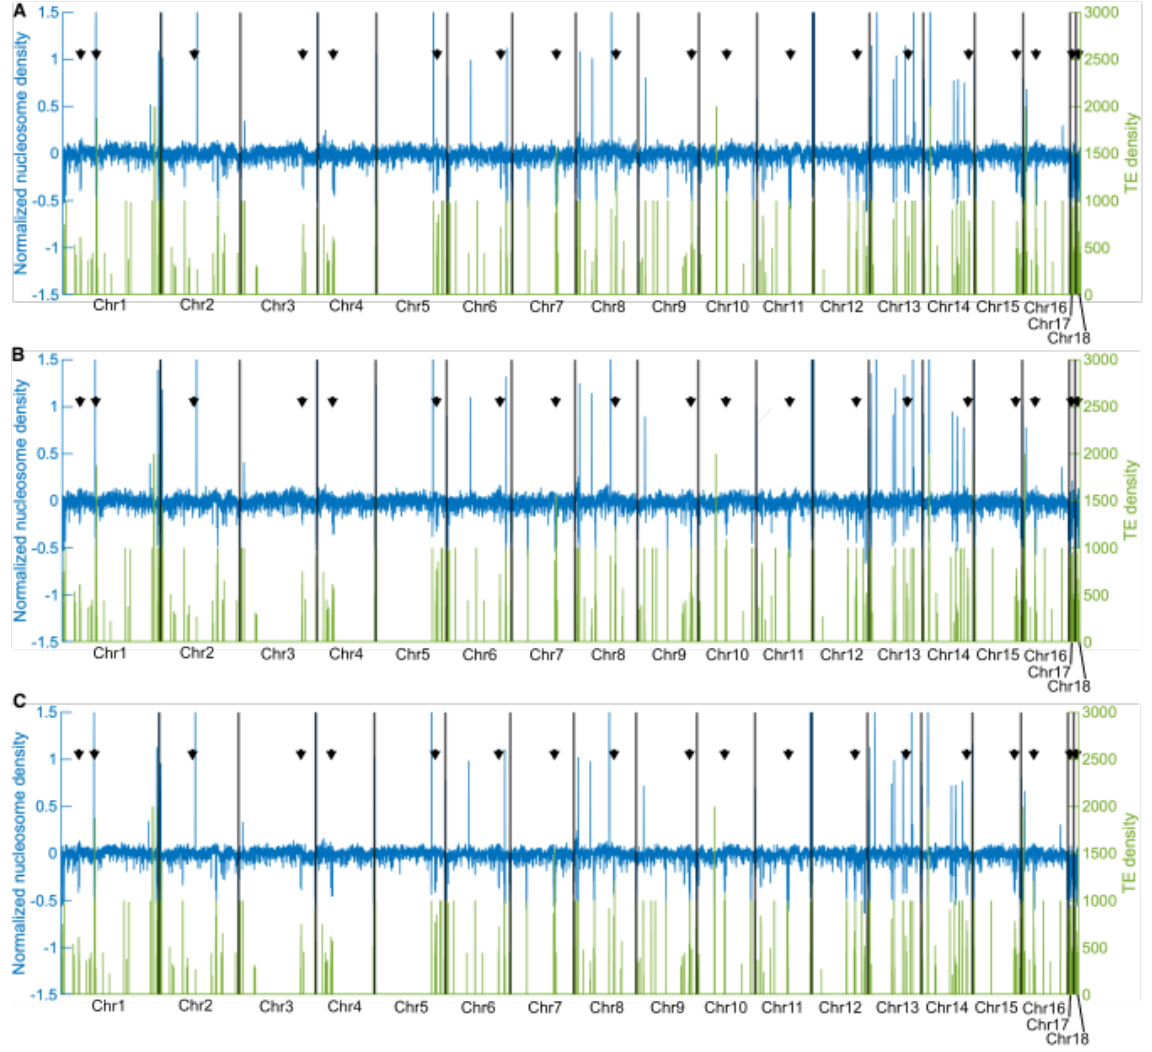
Supplementary Figure 3. Nucleosome vs . TE (other than BOTY) density profiles in individual biological replicates of Botrytis cinerea . Coverage density profiles were computed for non-overlapping 1 kb-long bins along the chromosomes. In green are plotted TE (excluding BOTY) density profiles as previously described (Diolez et al. , 1995). In blue are plotted the z-scored nucleosome density profiles. Black arrows indicate centromeres. ( A) . Biological replicate #1; ( B) . Biological Replicate #2; ( C) . Biological replicate